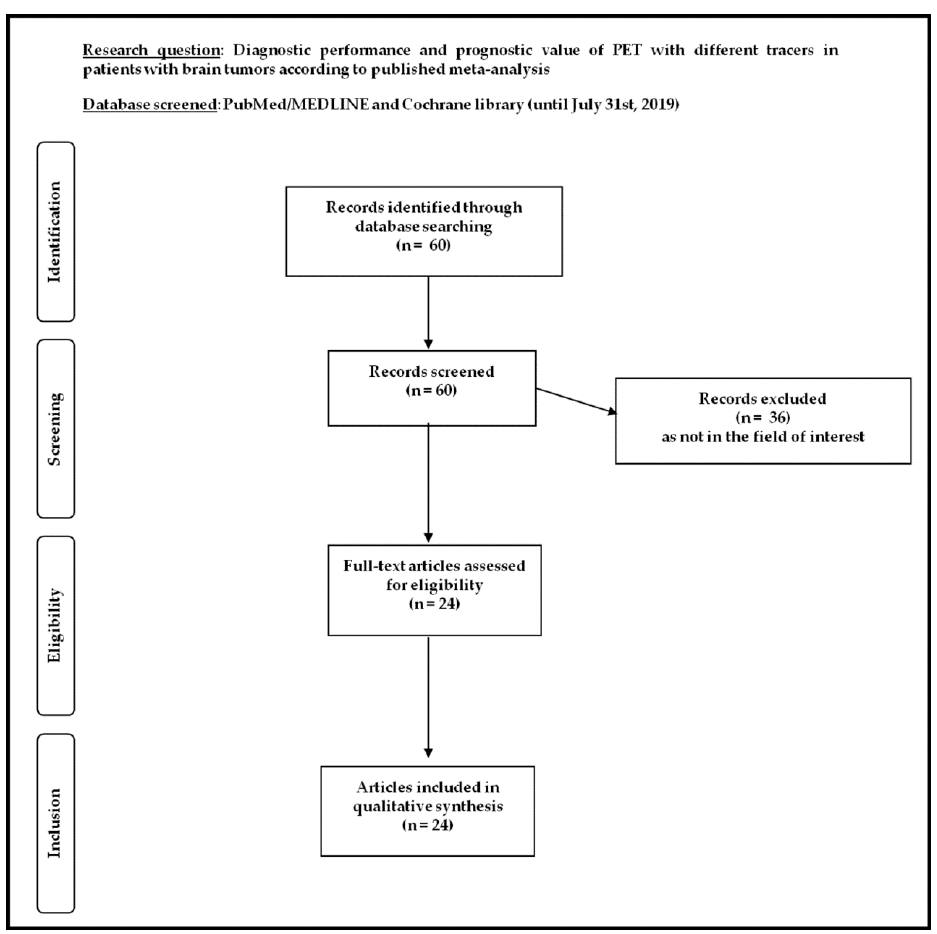
Figure 1. Flow chart of the search for meta-analyses on the diagnostic performance and prognostic value of positron emission tomography (PET) with di ff erent tracers in patients with brain tumors.